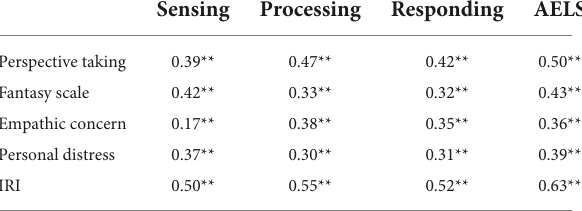
TABLE 6 Correlations between the studied dimensions. Sensing Processing